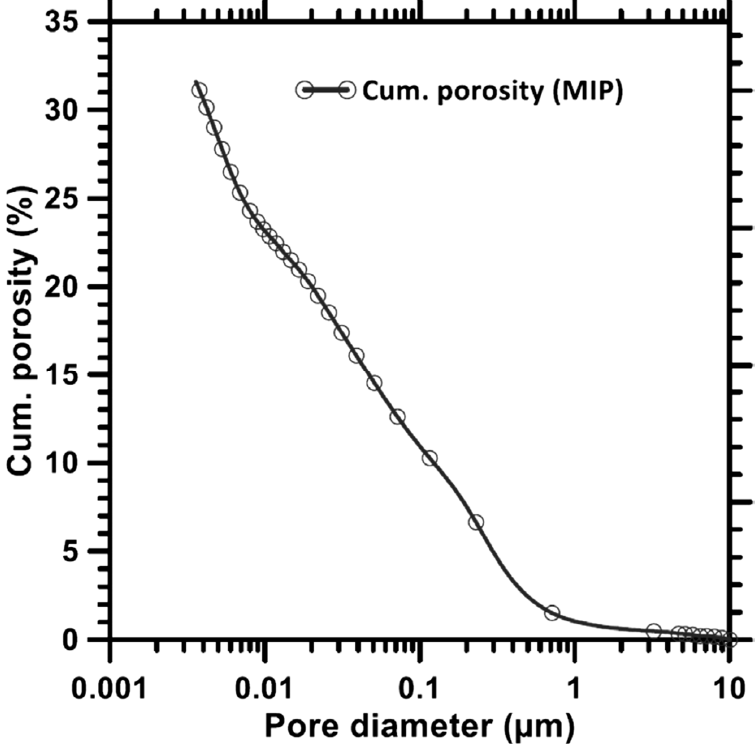
Figure 26. Cumulative mercury intrusion curve for alkali ‐ activated FA. Adapted from [110].